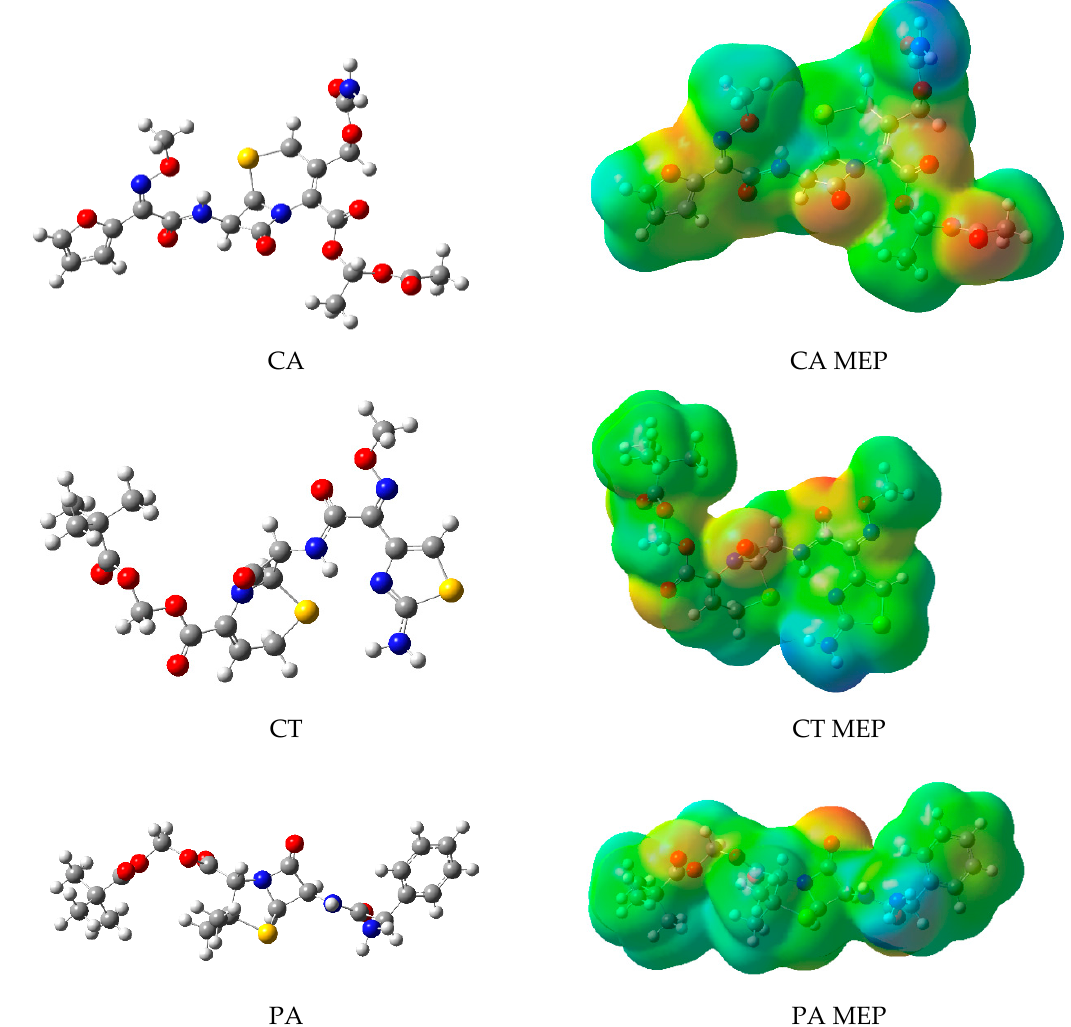
Figure 1. Optimized structure of prodrug β -lactam analogs and their maps of electrostatic potentials (MEPs).